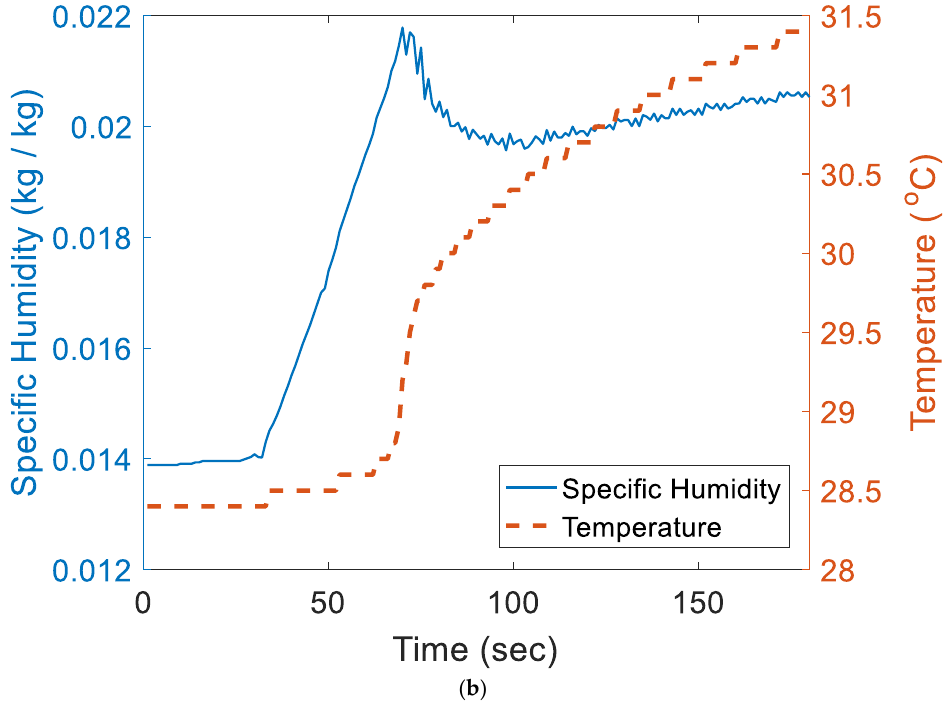
Figure 7. Varying patterns of temperature and moisture based on a data set from one of the 10 repeat trials. After the sensor was fully in contact with the mid left-thigh of the participant, the system remained in that position to record information for approximately 100 seconds: ( a ) relative humidity (RH) and temperature (T); ( b ) specific humidity (SH) and temperature where SH data were estimated using a humidity converter from the following website (http://www.humcal.com/index.php).